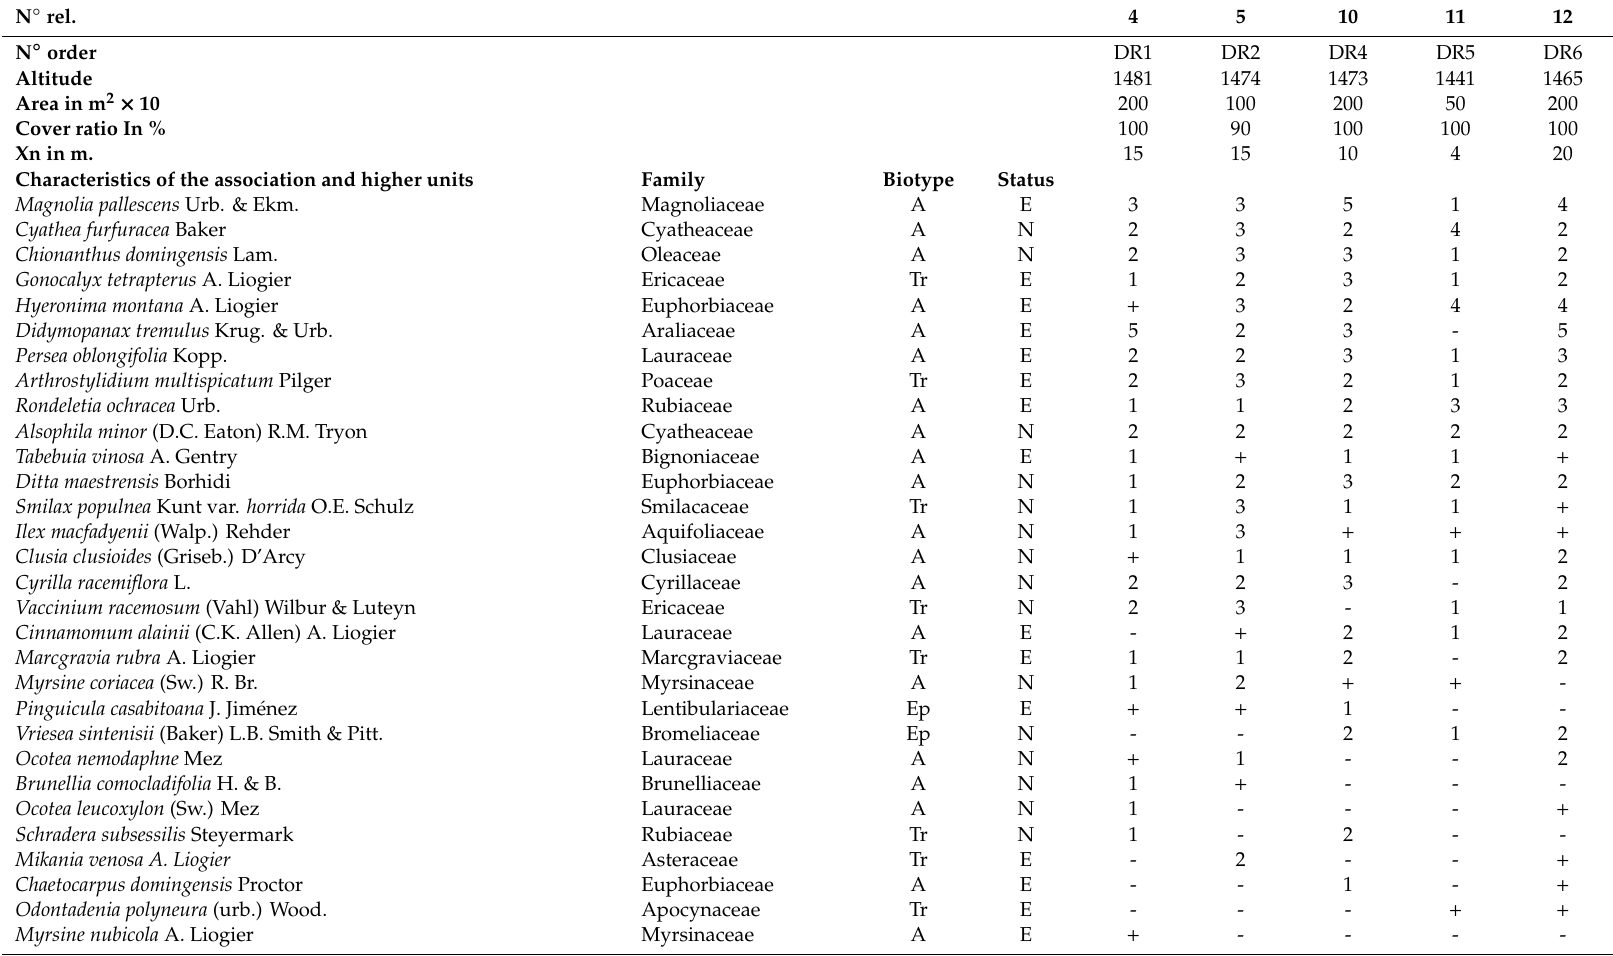
Table A1. Association Hyeronimo montanae-Magnolietum pallescentis.